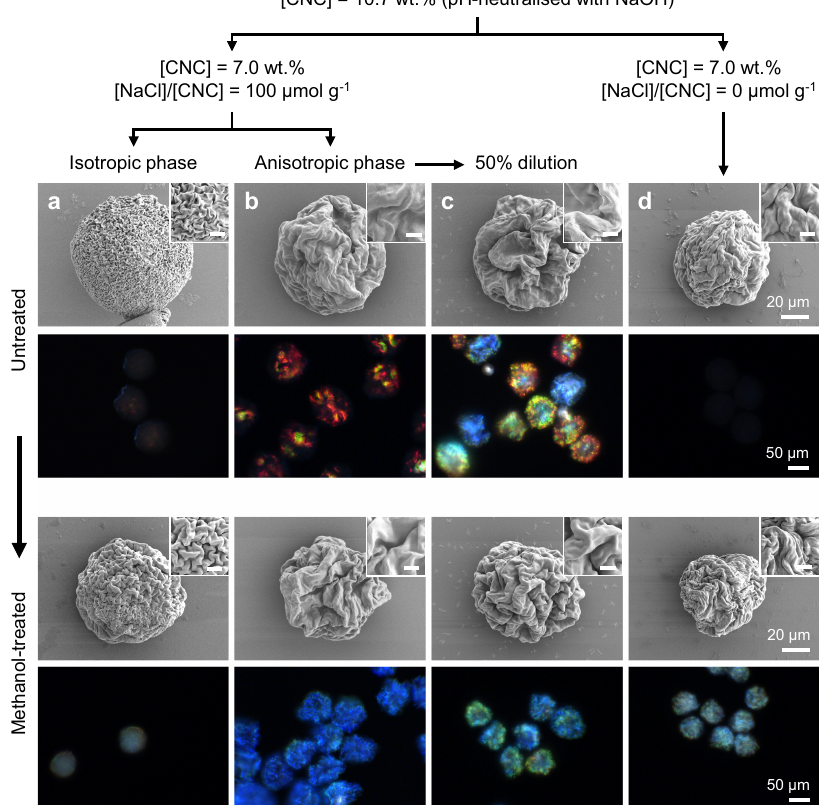
Fig. 6 The role of CNC suspension formulation on the morphology and visual appearance of the photonic microparticles. Scanning electron microscope and dark- fi eld optical microscope images of CNC microparticles produced from different formulations of the commercial CNC suspension, and recorded prior to (top), and after methanol treatment (bottom): For the standard conditions employed in this study ([CNC = 7.0 wt.% [NaCl]/[CNC] = 100 μ mol g − 1 ), the suspension phase separates into ( a ) an isotropic phase and ( b) an anisotropic phase. Microparticles produced from the anisotropic phase show vibrant colour, while those produced from the isotropic phase are only weakly coloured. c Diluting the anisotropic phase suspension in ( b ) by 50 vol.% with water to yield an isotropic suspension prior to emulsi fi cation results in vibrantly microparticles with a range of colours, which can be blueshifted upon further solvent treatment. d Diluting the same CNC source in the absence of any additional salt ([NaCl]/[CNC] = 0 μ mol g − 1 ) resulted in a fully anisotropic (i.e. unfractionated) suspension that produced less intense, redshifted microparticles. The SEM inset scalebar is 5 µ